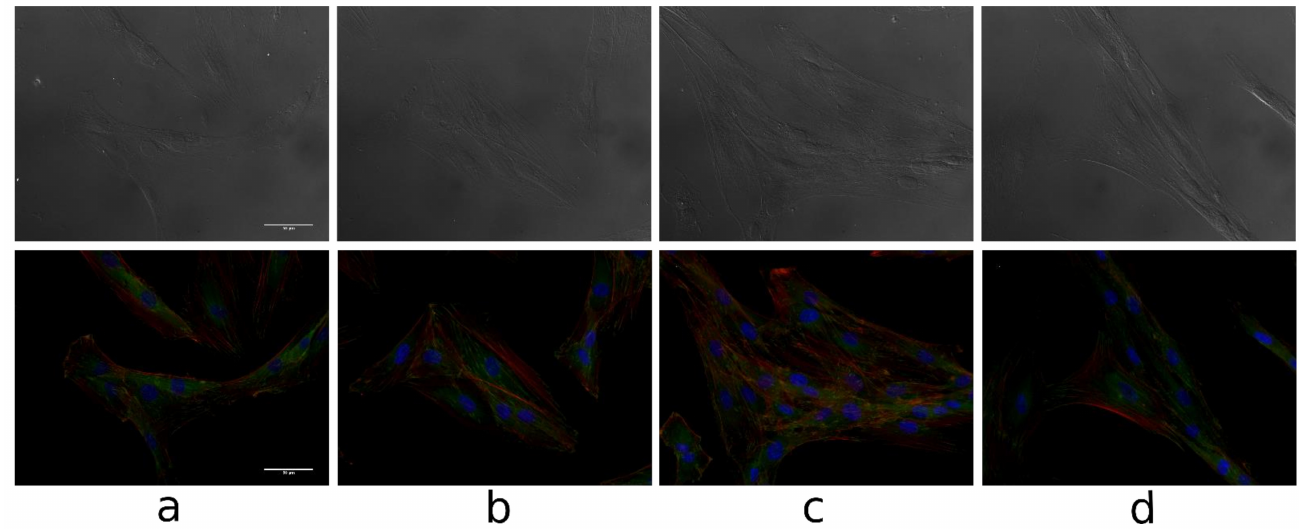
Figure 11. The microscopic images and the fluorescence microscopic images of fibroblasts after 24 h incubation with tested compounds (100 uM): control medium ( a ) lupeol acetate ( b ), lupeol isonicotinate ( c ) and lupeol acetylsalicylate ( d ). Scale bar = 500 µ m, 36l K cells (B) 3p, red color—actin fibers, green color—vinculin, blue color—cell nuclei (Hoechst Stain